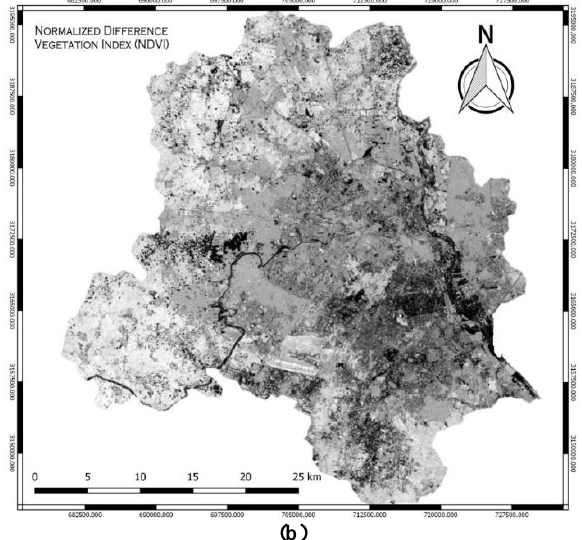
Figure 5 . (a) Tasselled Cap transformation (Greenness Map); (b) NDVI Image 6.